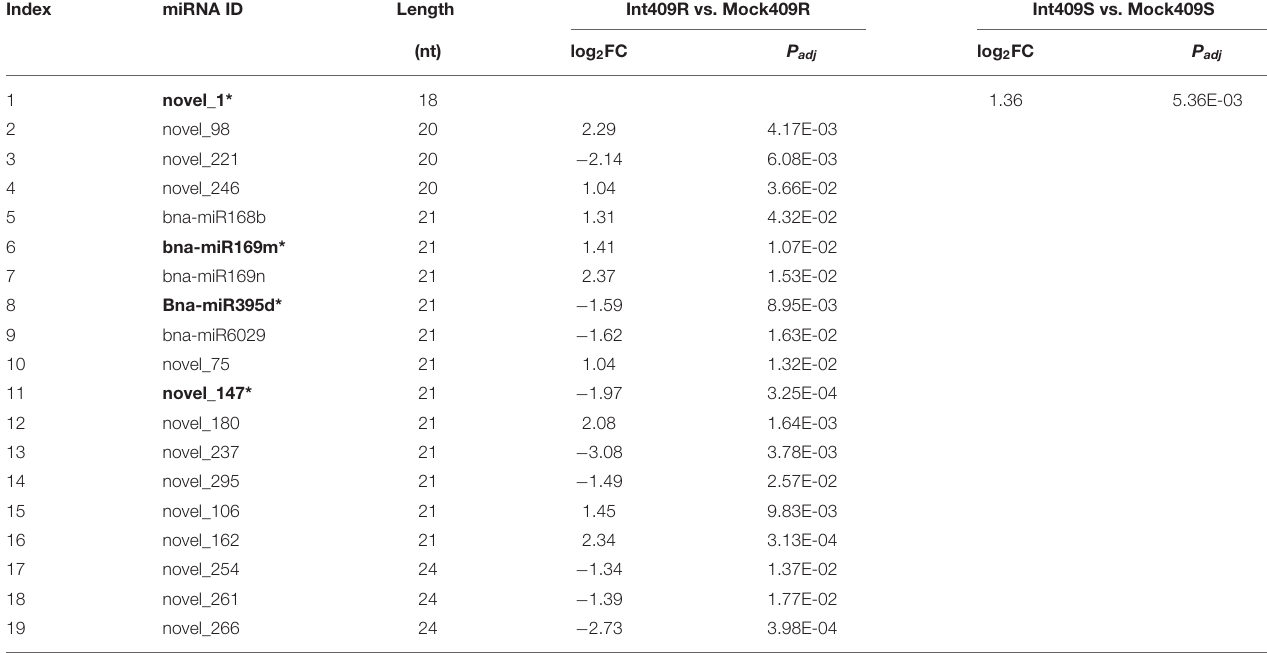
TABLE 3 | Differentially expressed miRNAs in response to P. brassicae infection ( p < 0.05, |log 2 FC| > 1).